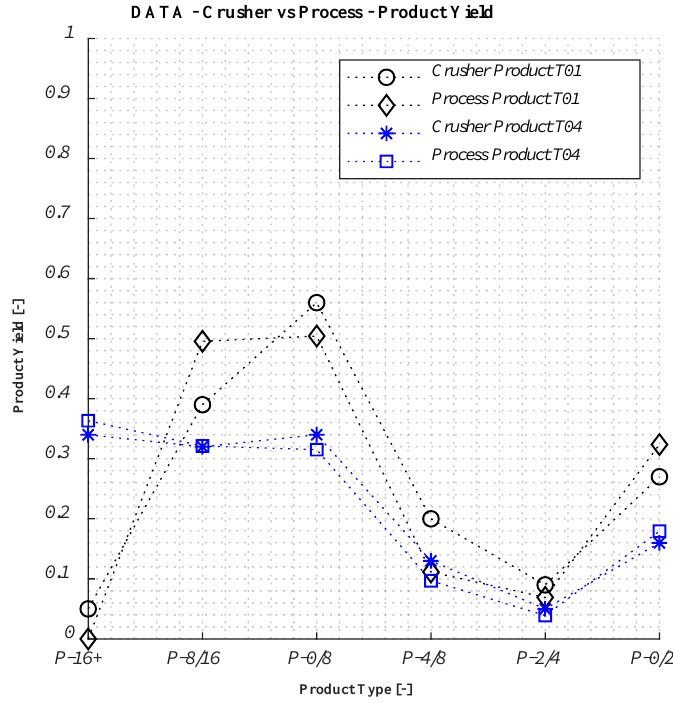
Figure 17. Product yield for different product streams obtained from data from crusher and process performance.